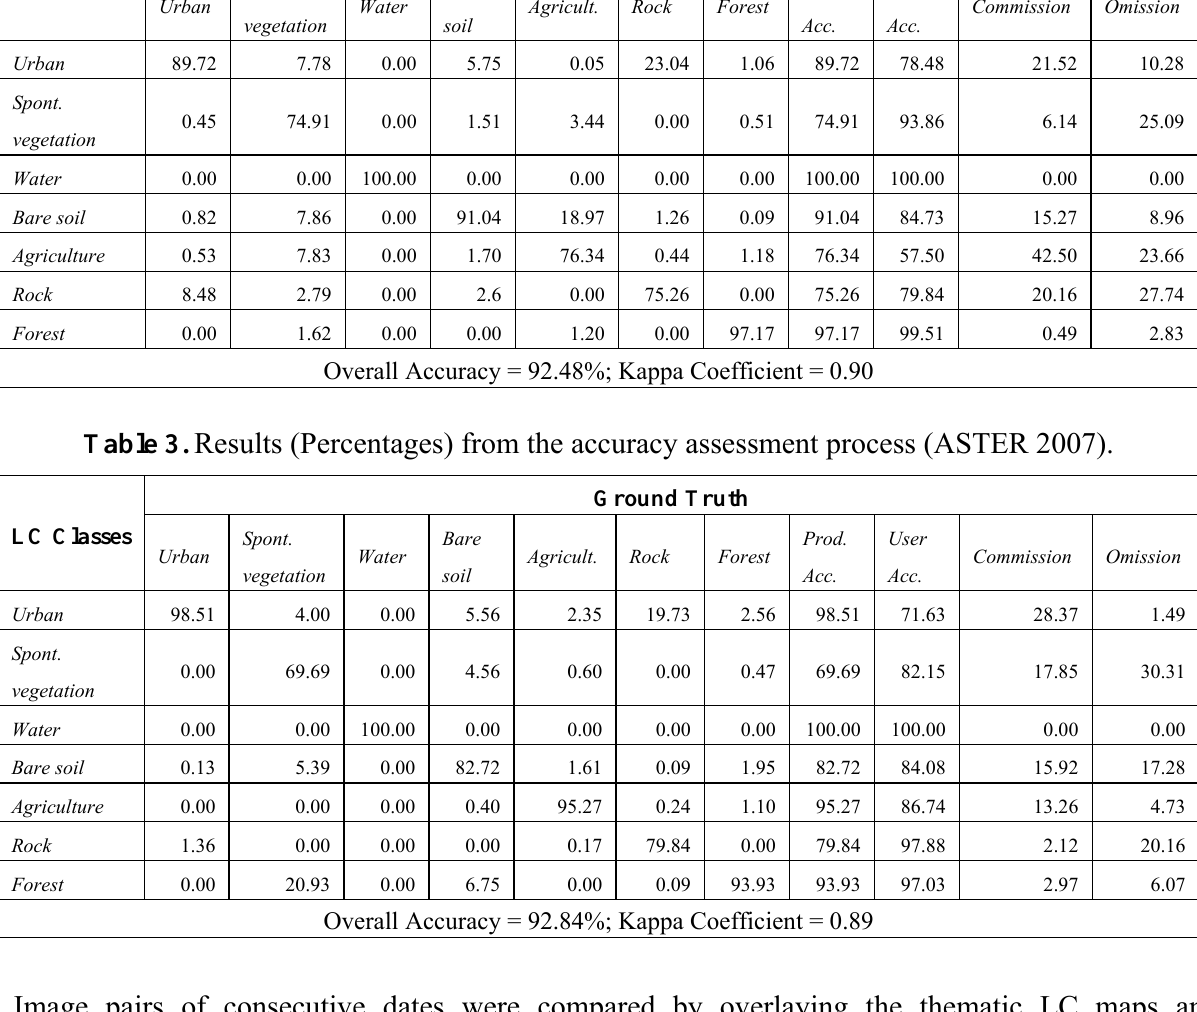
Table 2. Results (Percentages) from the accuracy assessment process (ASTER 2003). LC Classes